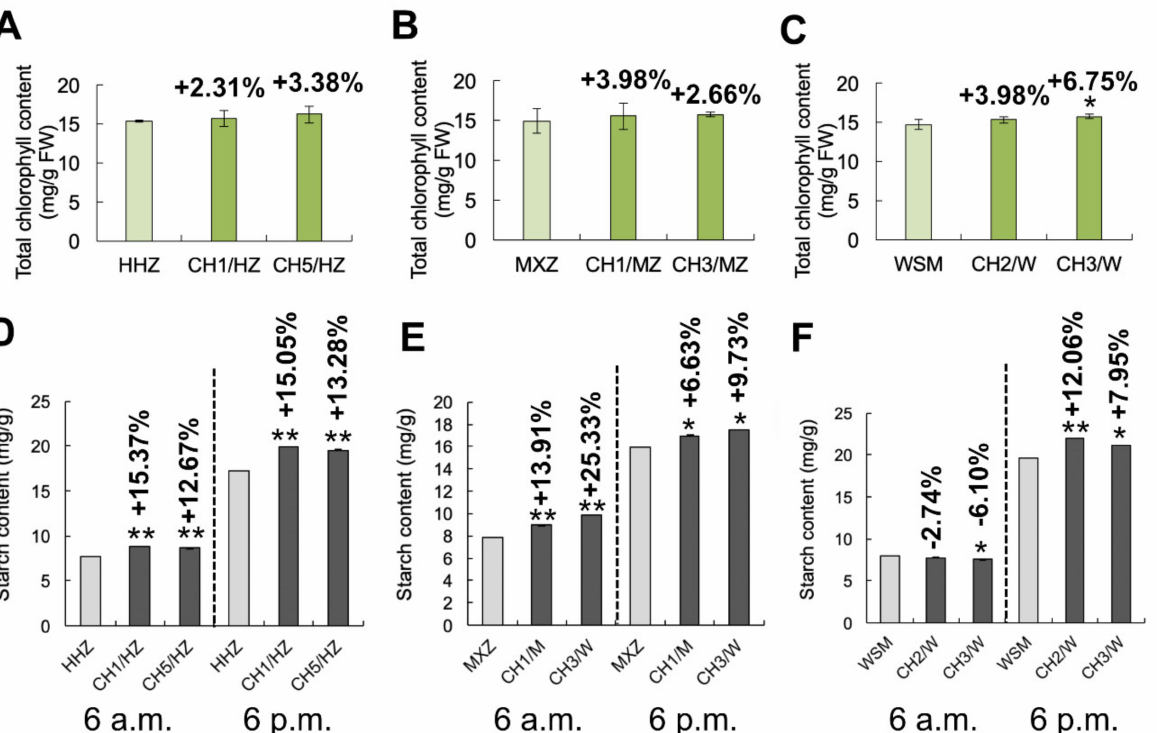
Figure 5. Measurement of chlorophyll and total starch contents in the three varieties. ( A – C ) The total chlorophyll contents in HHZ, MXZ, WSM, CH1/HZ, and OsHXK1-Cas9 plants during the flowering stage. Shown are the means ± SDs; *, p < 0.05; **, p < 0.01 according to Student’s t -test. ( D – F ) Total starch contents in leaves of HHZ, MXZ, WSM, and CH1/HZ and OsHXK1-Cas9 plants at the flowering stage in the morning and evening. Shown are the means ± SDs; *, 0.01 ≤ p < 0.05; **, 0.001 ≤ p < 0.01, according to Student’s t